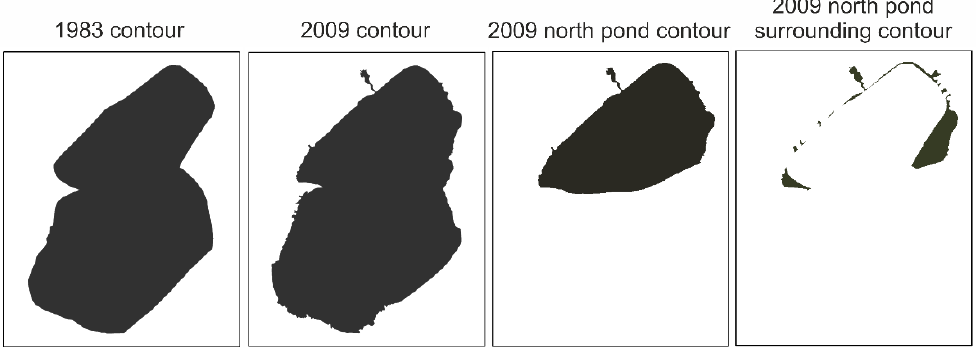
Figure 2. Schematic example of the masks applied with the ArcGIS cut-and-fill tool to calculate the volume difference in specific areas of the pond between 1983 and 2009. The volumes of the south pond and the entire perimeter were calculated by mathematical relations.